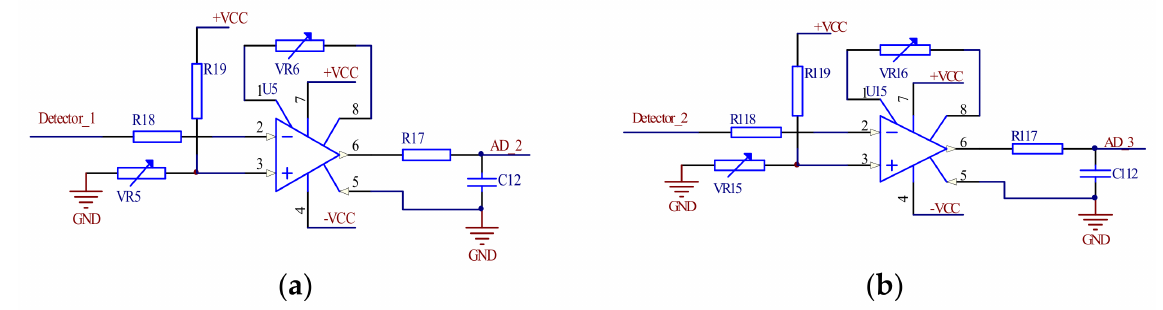
Figure 10. Double detector signal acquisition circuit. ( a ) Circuit of detector 1. ( b ) Circuit of detector 2.